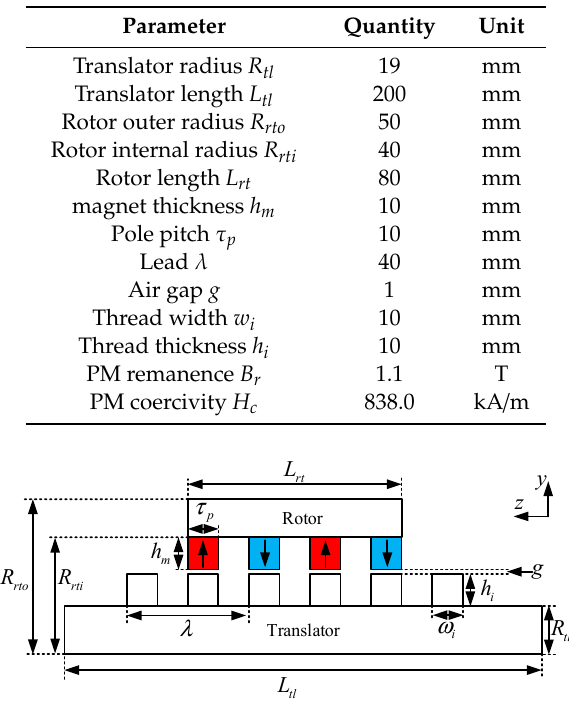
Table 1. Initial parameters of the RLS.